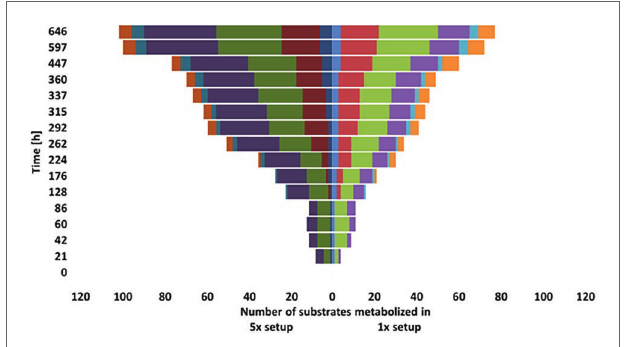
FIGURE 7 | Comparison of substrate utilization by the microbial communities from the DOM-1x and DOM-5x fed sediments.